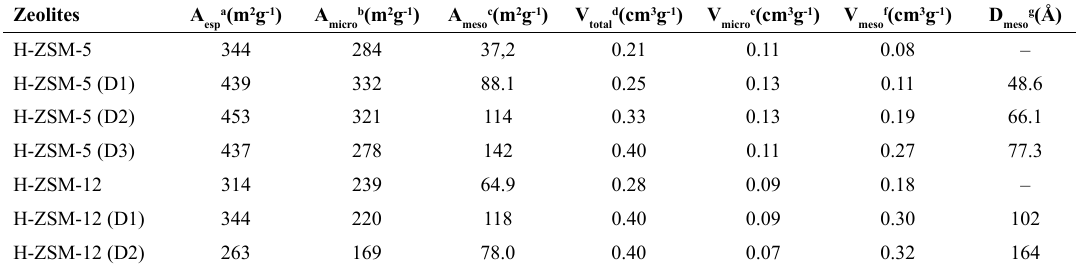
Figure 3. Mesopore size distribution before and after desilication. a) H-ZSM-5 and b) H-ZSM-12. Table 3. Textural parameters of the standard and desilicated